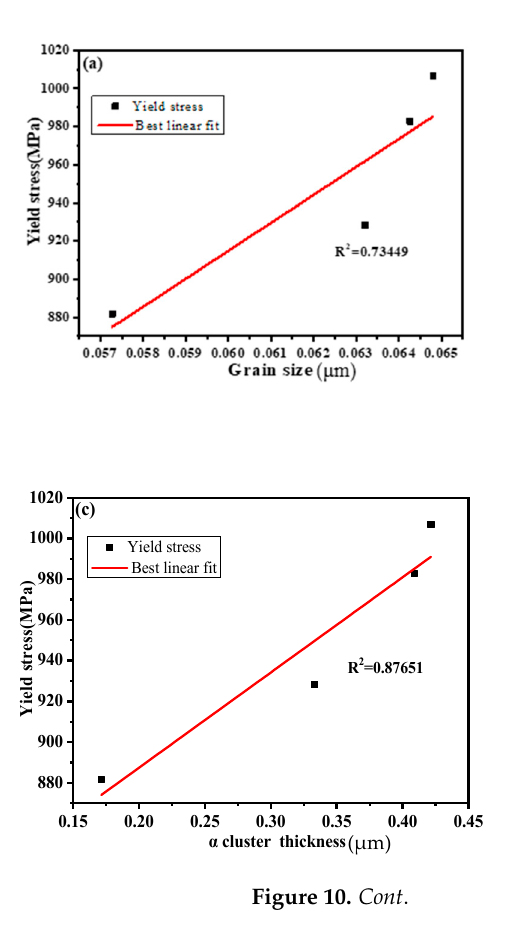
Figure 10. Hall–Petch relationship between yield stress and microstructure parameters including ( a ) Grain size dg, ( b ) α platelet thickness T α , ( c ) α colony thickness Tc, ( d ) thickness of GB TGB, and ( e ) α + β platelet thickness T α + β . 3.5.2. Crack Initiation and Propagation For a bicrystal, the applied stress on α and β phase can be given by Equation (2) under a single stress condition [35]: σ (cid:2961) = (cid:4666)σA(cid:4667)/(cid:3427)A (cid:2961) + (cid:3435)E (cid:2962) A (cid:2962) /E (cid:2961) (cid:3439)(cid:3431) σ (cid:2962) = (cid:4666)σA(cid:4667)/(cid:3427)A (cid:2962) + (cid:3435)E (cid:2961) A (cid:2961) /E (cid:2962) (cid:3439)(cid:3431)